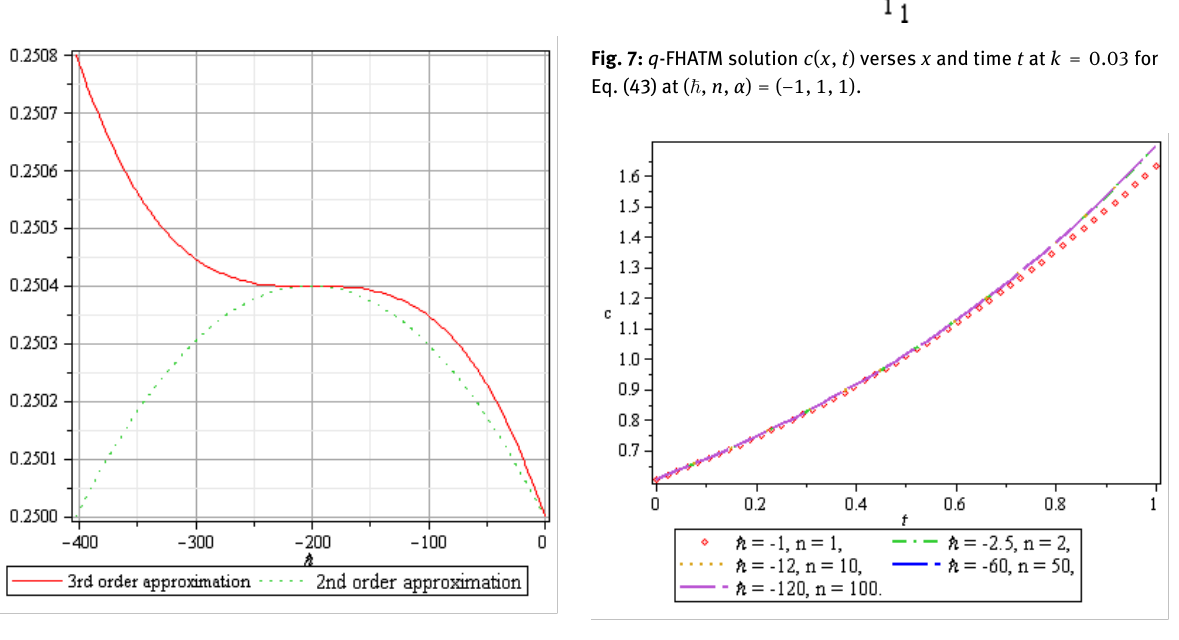
Fig. 8: q -FHATM solution c ( x , t ) for Eq. (43) when k = 0.03, x = 0.5, α = 1 for different values of (cid:126) and n . ily settle and restrict the region of convergence of series so- lution derived with the aid of q -FHATM by choosing suit- able values of (cid:126) and n in a large